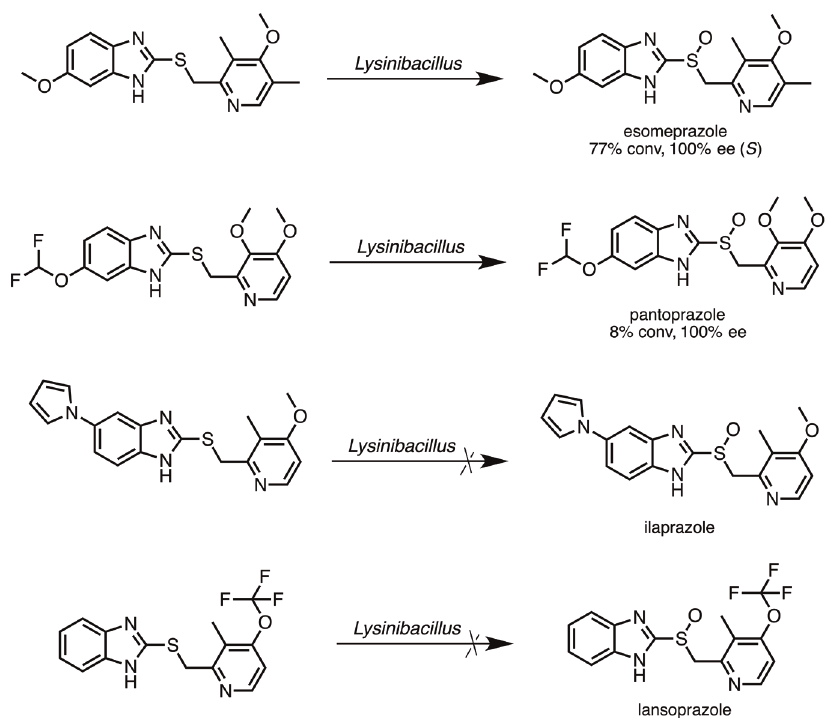
Figure 31 - Esomeprazole sulfide and other related compounds used as substrates for biooxidations with Lysinibacillus sp. B71 (Babiak et al.